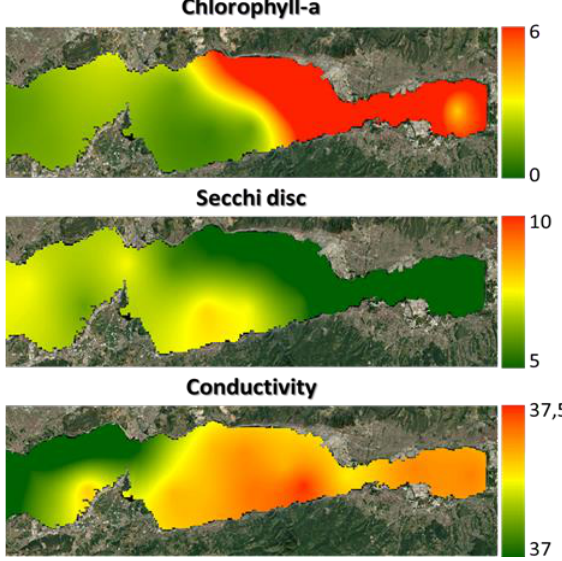
Figure 5. The spatial distribution patterns of three selected water quality parameters produced by the ordinary Kriging interpolation method.